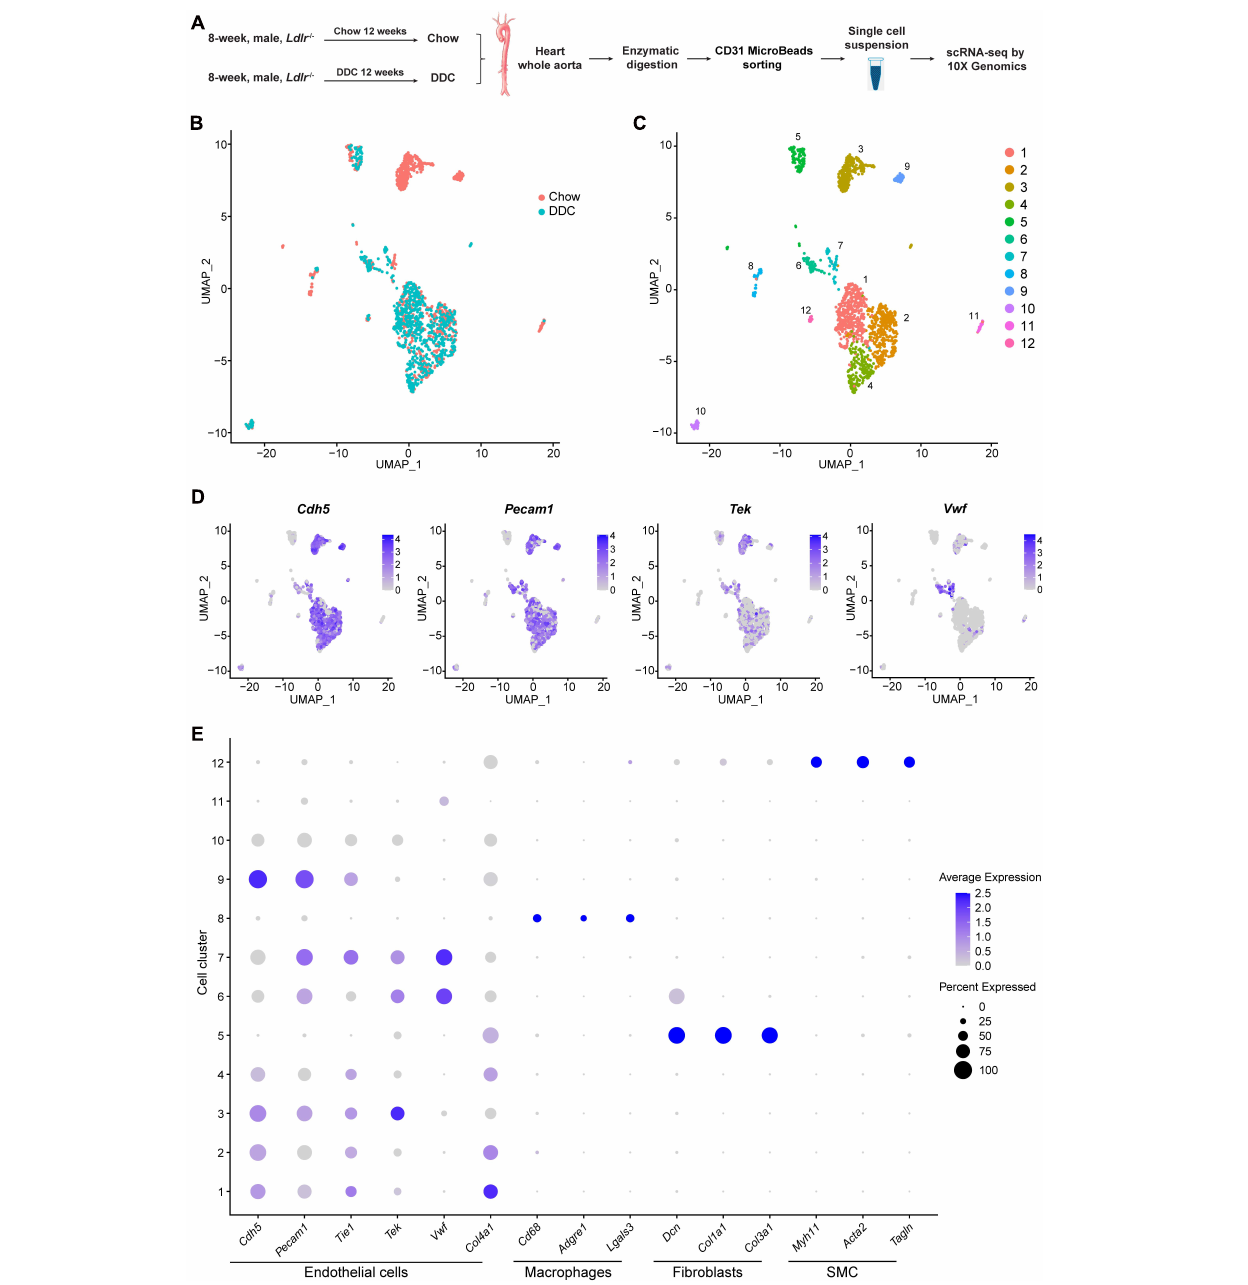
FIGURE 1 | Identification of cell clusters present in the mouse heart and aorta by single-cell RNA sequencing (scRNA-seq). (A) , Schematic diagram indicating the procedure for scRNA-seq. Chow, Ldlr − / − mice fed a standard chow for 12 weeks. DDC, Ldlr − / − mice fed a diabetogenic diet with 0.15% cholesterol for 12 weeks. The cells isolated from each group were pooled from three mice. (B) , Uniform Manifold Approximation and Projection (UMAP) plot of aggregate cells from Chow and DDC group. Colors denote different groups. After quality control, 1014 and 770 cells from Chow and DDC were captured for clustering analysis. (C) , UMAP plot of aggregated cells from the three groups with colors denoting different cell clusters. (D) , Expression of endothelial cell (EC) marker genes ( Cdh5 , Pecam1 , Tek, and Vwf ) was visualized by Feature plots. (E) , Dot plot of selected marker genes for each cluster and lineage. Dot size indicates the percentage of cells expressing each gene, and dot color represents the average expression level. SMC, smooth muscle